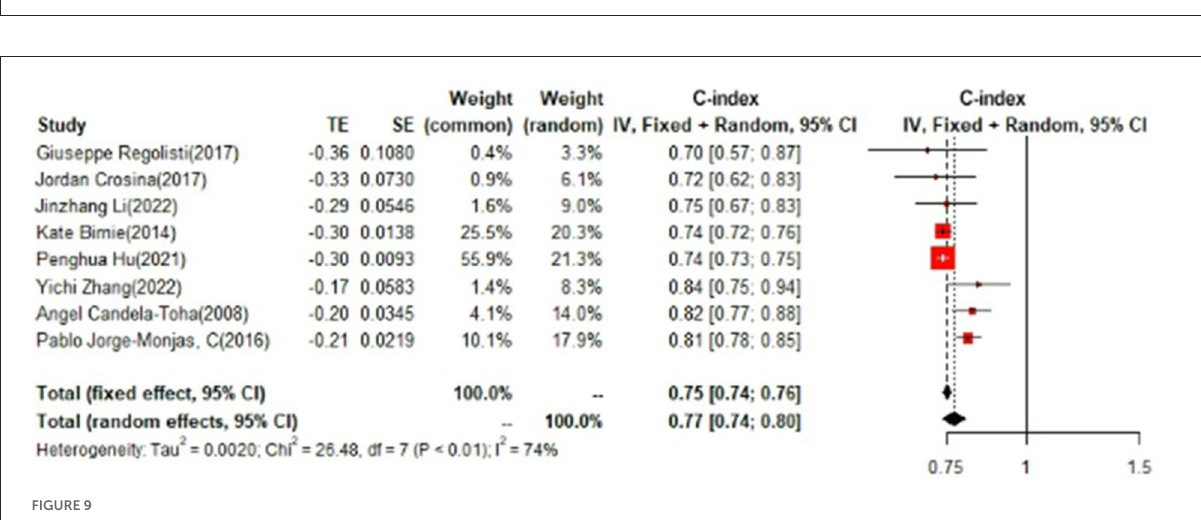
FIGURE8 C-index in the training set: other models.